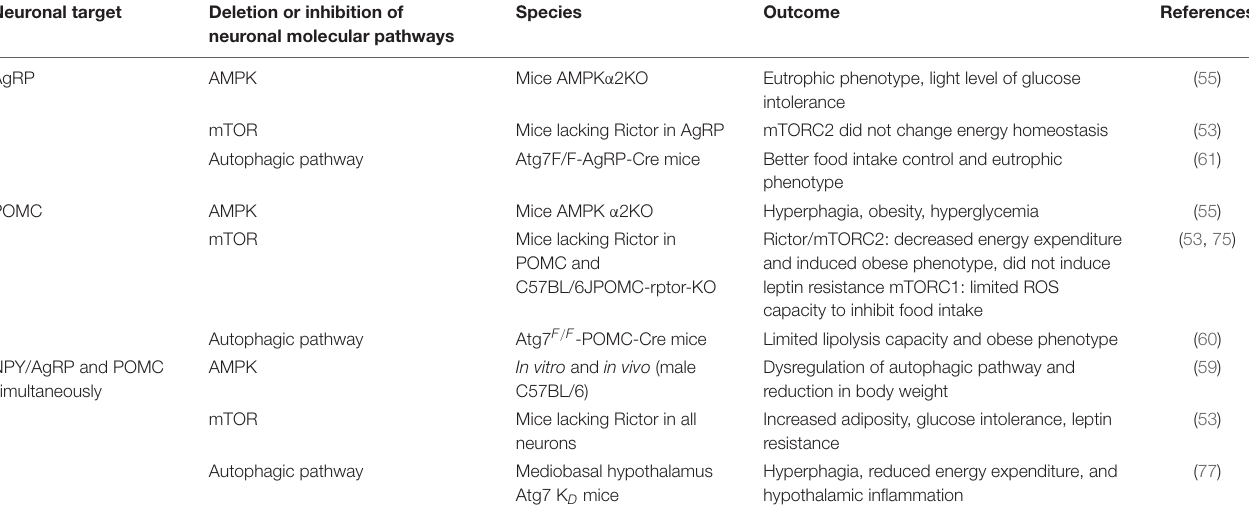
TABLE 1 | Molecular pathway deletion or inhibition in the neuronal subgroups and the outcomes. Neuronal